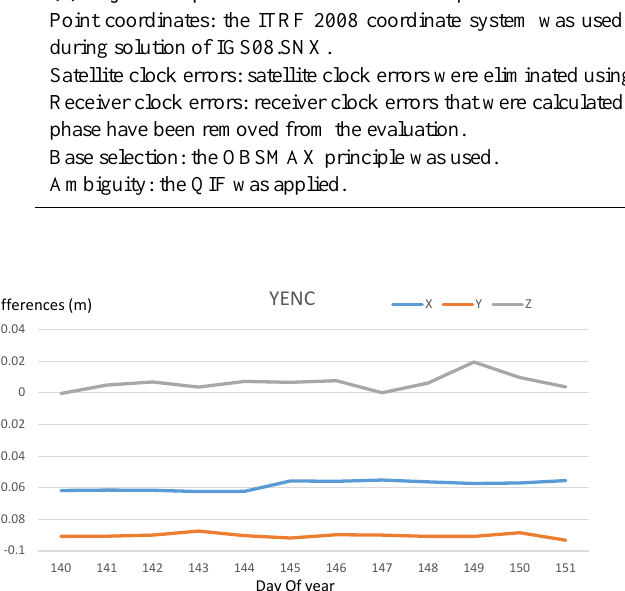
Figure 13. YENC station coordinate